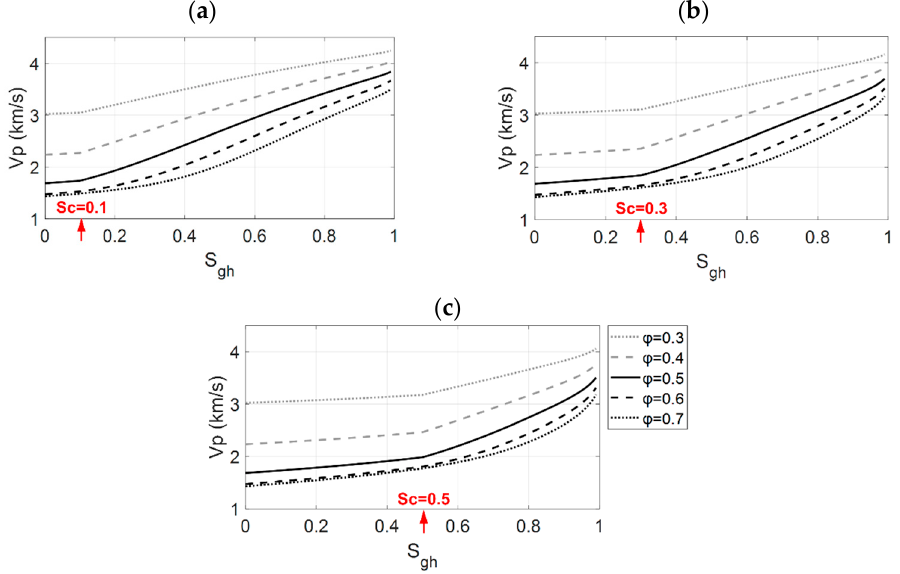
Figure 4. The computed P-wave velocity ( V P ) in terms of the gas hydrate saturation ( S gh ) with varying porosity for three levels of the critical gas hydrate saturation ( S c ): ( a ) 0.1, ( b ) 0.3, and ( c ) 0.5.